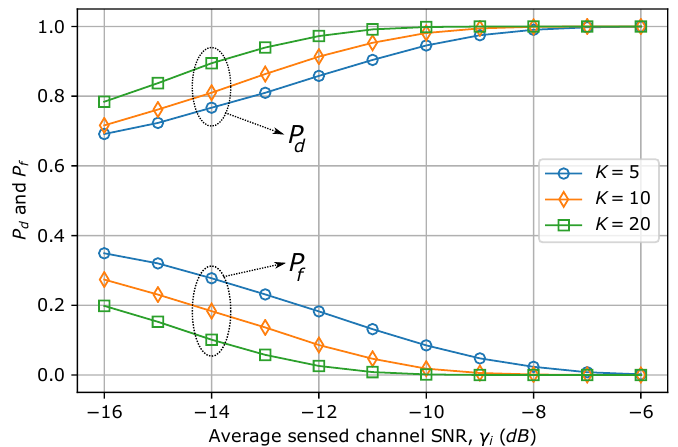
Figure 9. Probabilities of detection and false alarm with the proposed CBCSS according to average SNRs when the number of SUs, K , changes.